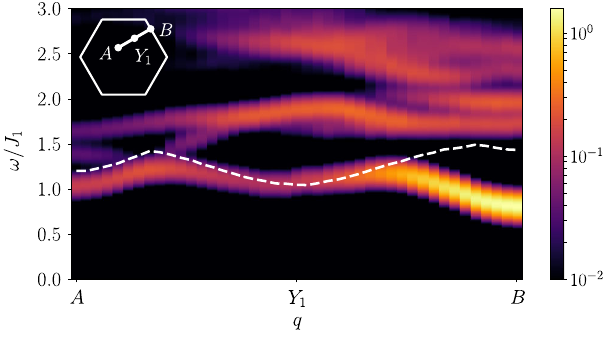
FIG. 6. The dynamical structure factor for the nearest-neighbor Heisenberg model on a cylindrical geometry ( 84 × 6 ), to make a close comparison with DMRG calculations by Verresen et al. [32]. We apply a Gaussian broadening to the spectrum, which is equivalent to the one of the aforementioned DMRG result ( σ ¼ 0 . 077 J 1 ). The path in the Brillouin zone is shown in the inset and in Fig. 1 [point A lies at 1 = 4 of the Γ − K 00 line, where ffiffiffi p K 00 ¼ð − 2 π = 3 ; 2 π = 3 Þ , and point B lies at 1 = 4 of the K − K 0 line]. The dashed line denotes the bottom of the continuum, which is evaluated by taking E q ¼ min f E q − K 0 þ E K 0 ; E q þ K 0 þ E − K 0 g , where E q q obtained within ffiffiffi 0 is the lowest energy for a given momentum p 3 our variational approach and K ¼ ð 2 π = 3 ; 2 π = Þ . FIG. 7. The dynamical structure factor for the J 1 − J 2 Heisen- berg model on the 30 × 30 cluster with J 2 =J 1 ¼ 0 . 07 (top) and J =J 0 . 09 (bottom). The path along the Brillouin zone is 2 1 ¼ shown in Fig. 1, and a Gaussian broadening of the spectrum has been applied ( σ ¼ 0 . 02 J 1